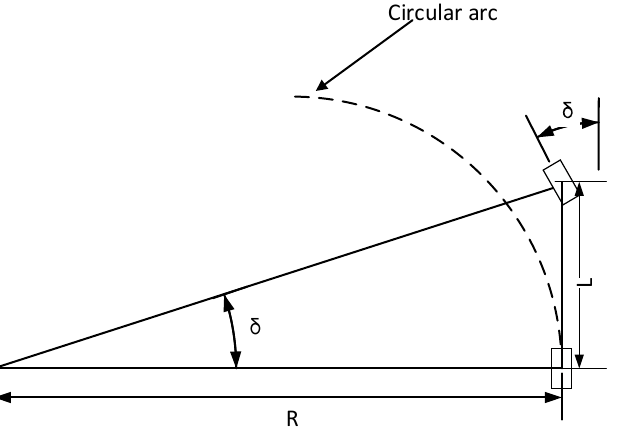
Figure 2. Geometric model based on Ackerman steering configuration.